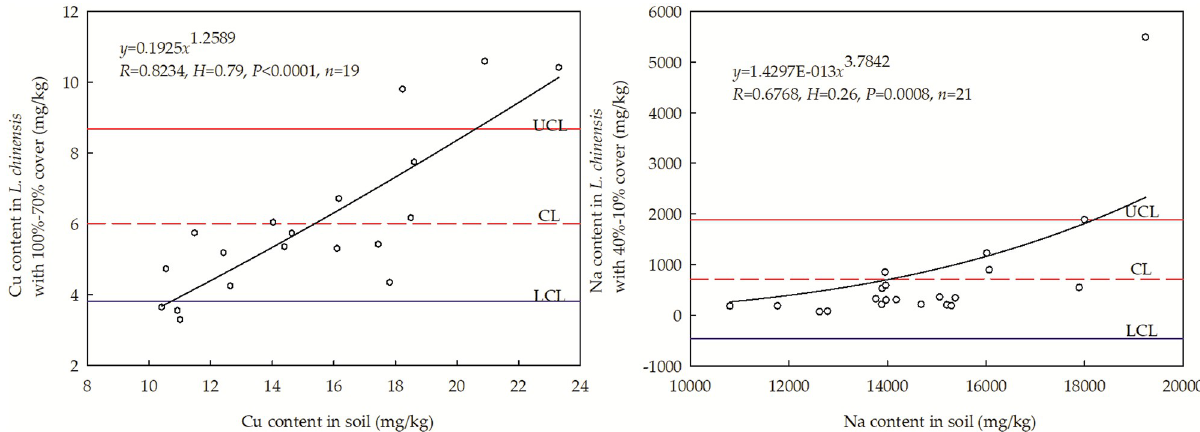
Fig 3. Homeostatic characteristics of two elements (Cu and Na) whose measured concentrations were significantly related to those of nitrogen in L . chinensis . (Note: The degree of homeostasis of an element in a given species is determined by its H-value; the species exhibits homeostasis of the element if H > 4, weak homeostasis if 2 < H < 4, weak sensitivity if 4/3 < H < 2, and sensitivity if H < 4/3 [36]. The labels UCL, CL and LCL denote the upper control line, control line, and lower control line (based on a 95% confidence interval),